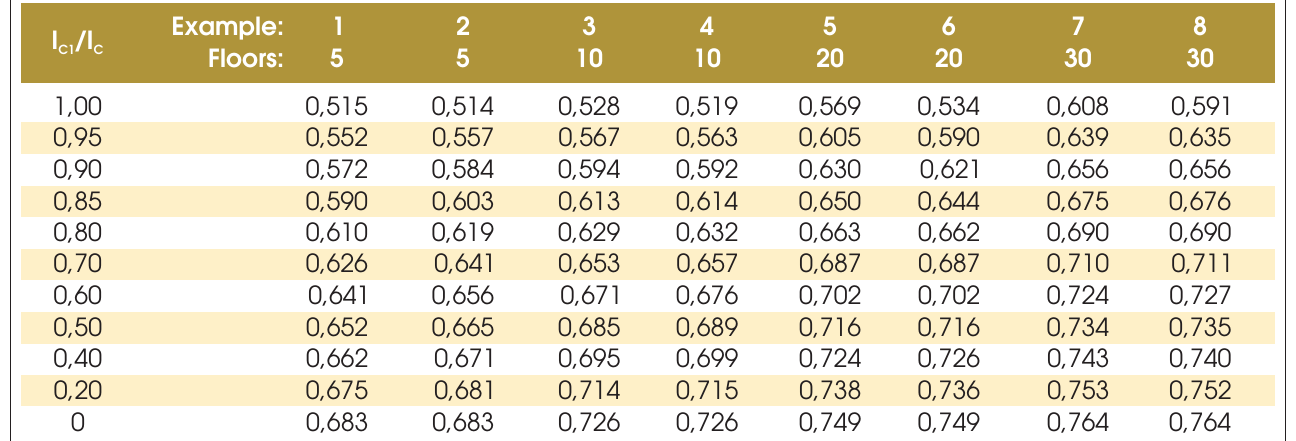
Table 5 – Values of a , varying the I /I ratio and the numbers of floors and spans